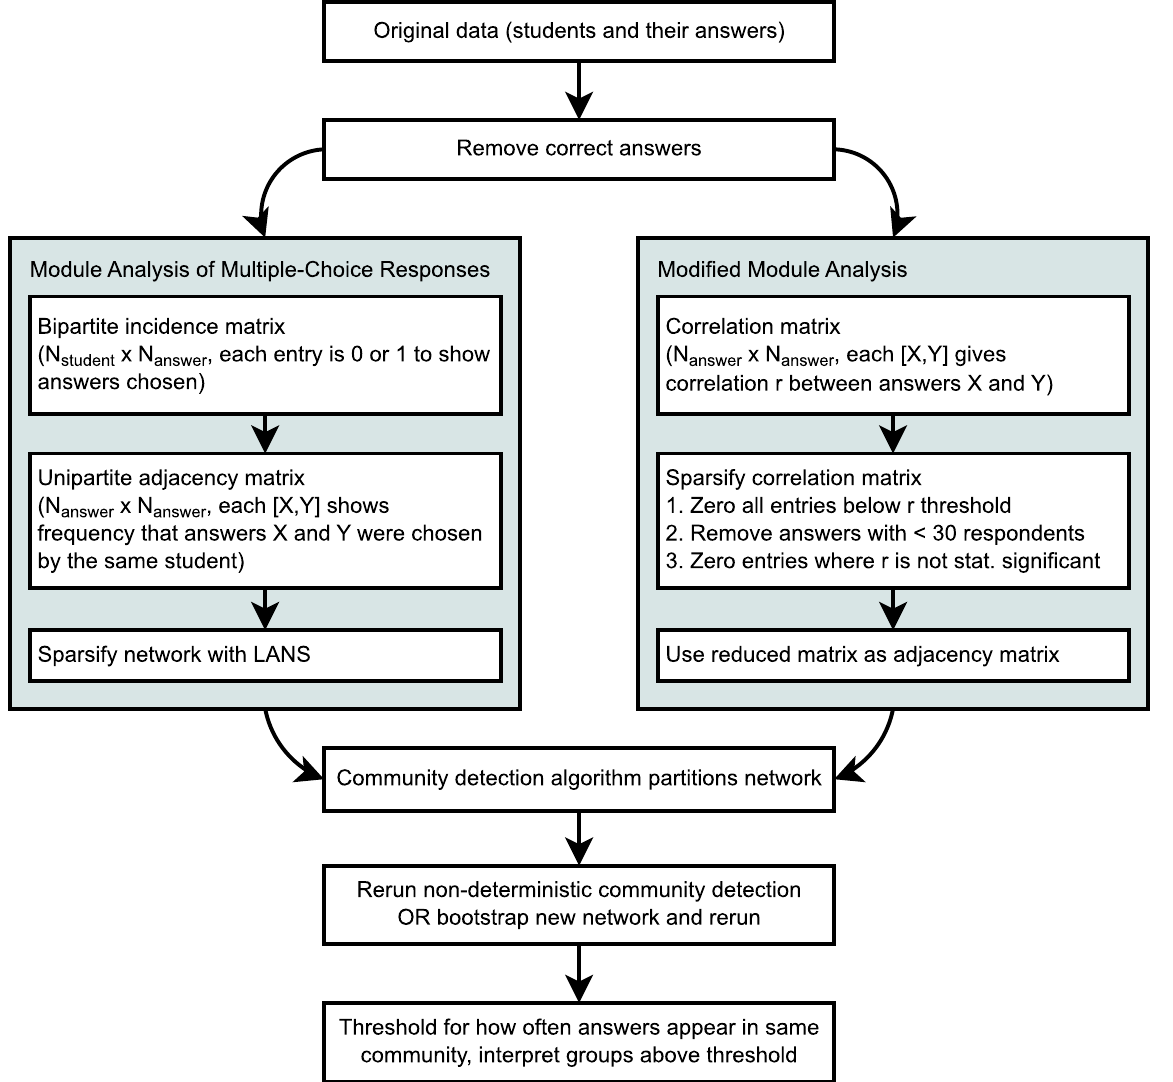
FIG. 1. Workflow of analysis for the original module analysis method (left branch) and our modified version (right